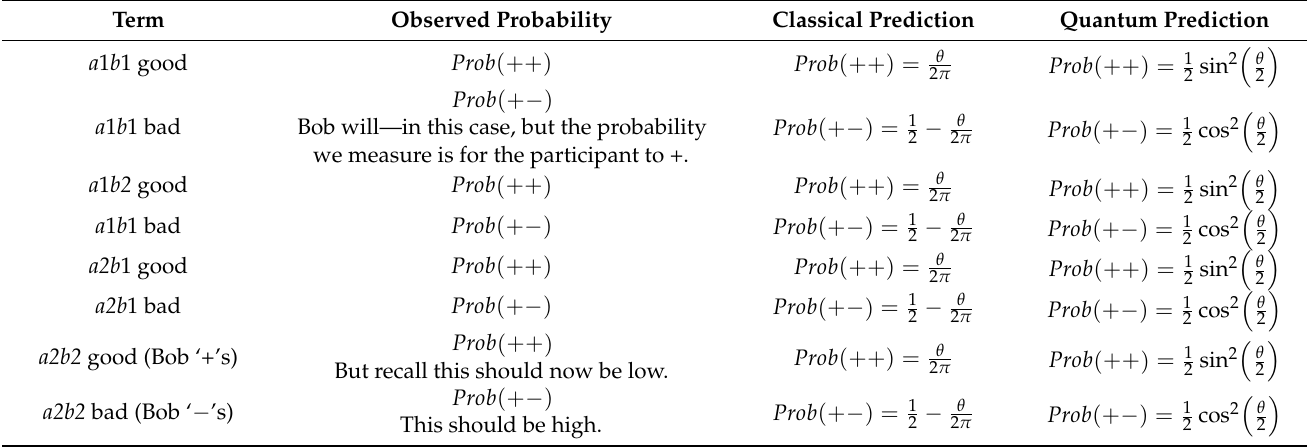
Table 8. Correspondence between observed probabilities and predictions from the classical and quantum models. Term Observed Probability Classical Prediction Quantum